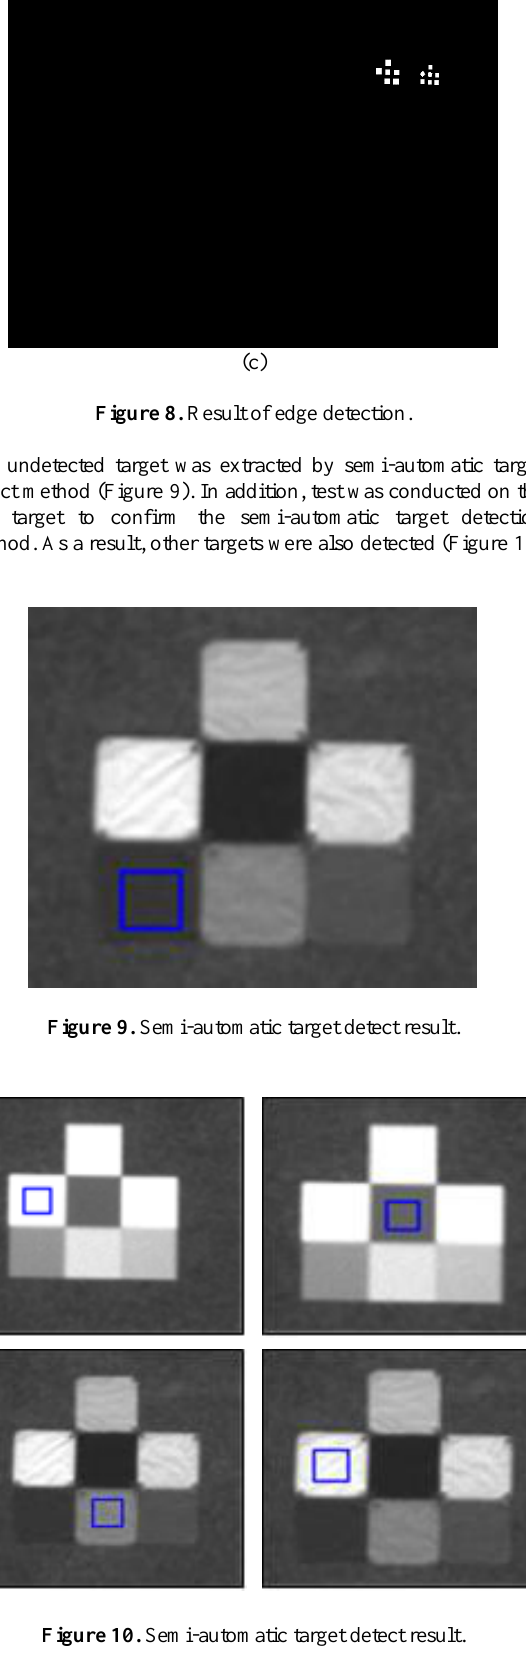
Figure 10. Semi-automatic target detect result.